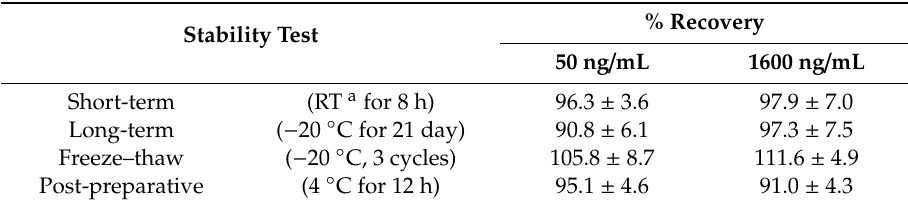
Table 2. Stability of ATEC in rat